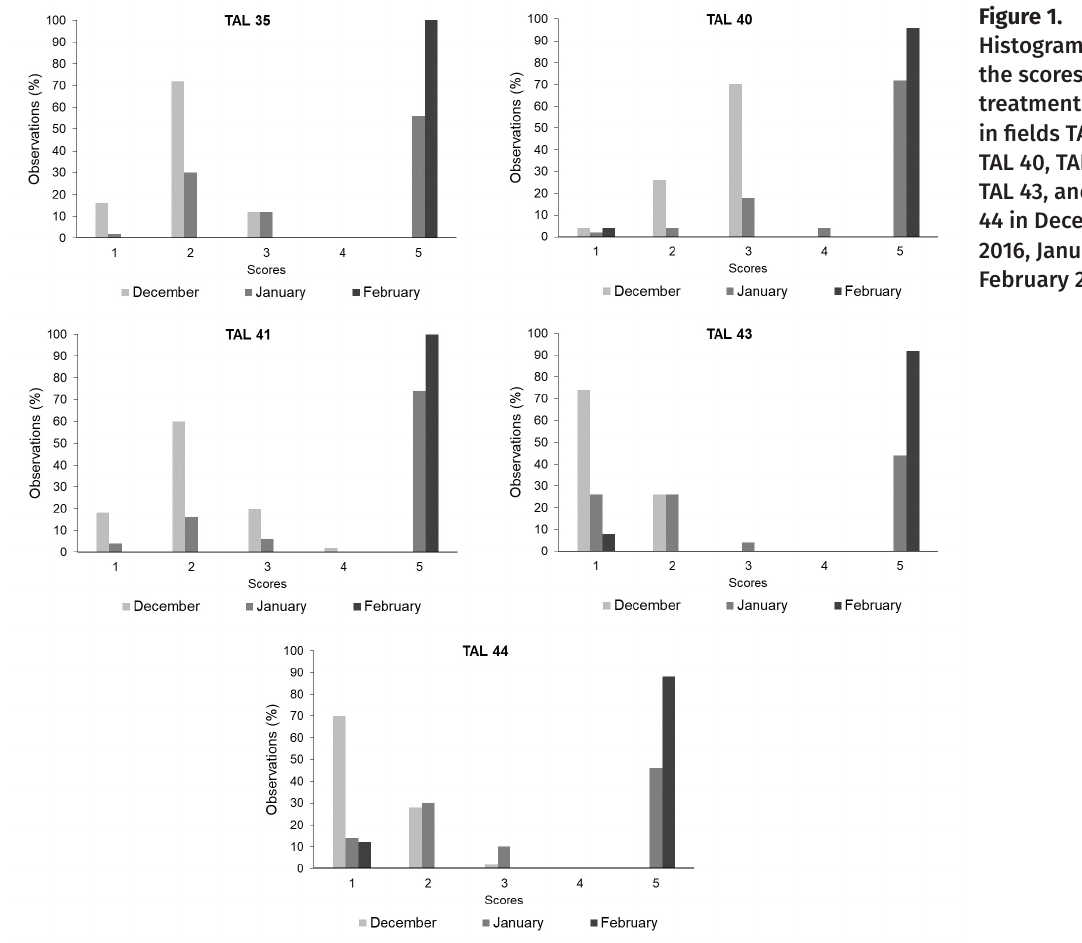
Figure 1. Histograms of the scores for treatment T01 in fields TAL 35, TAL 40, TAL 41, TAL 43, and